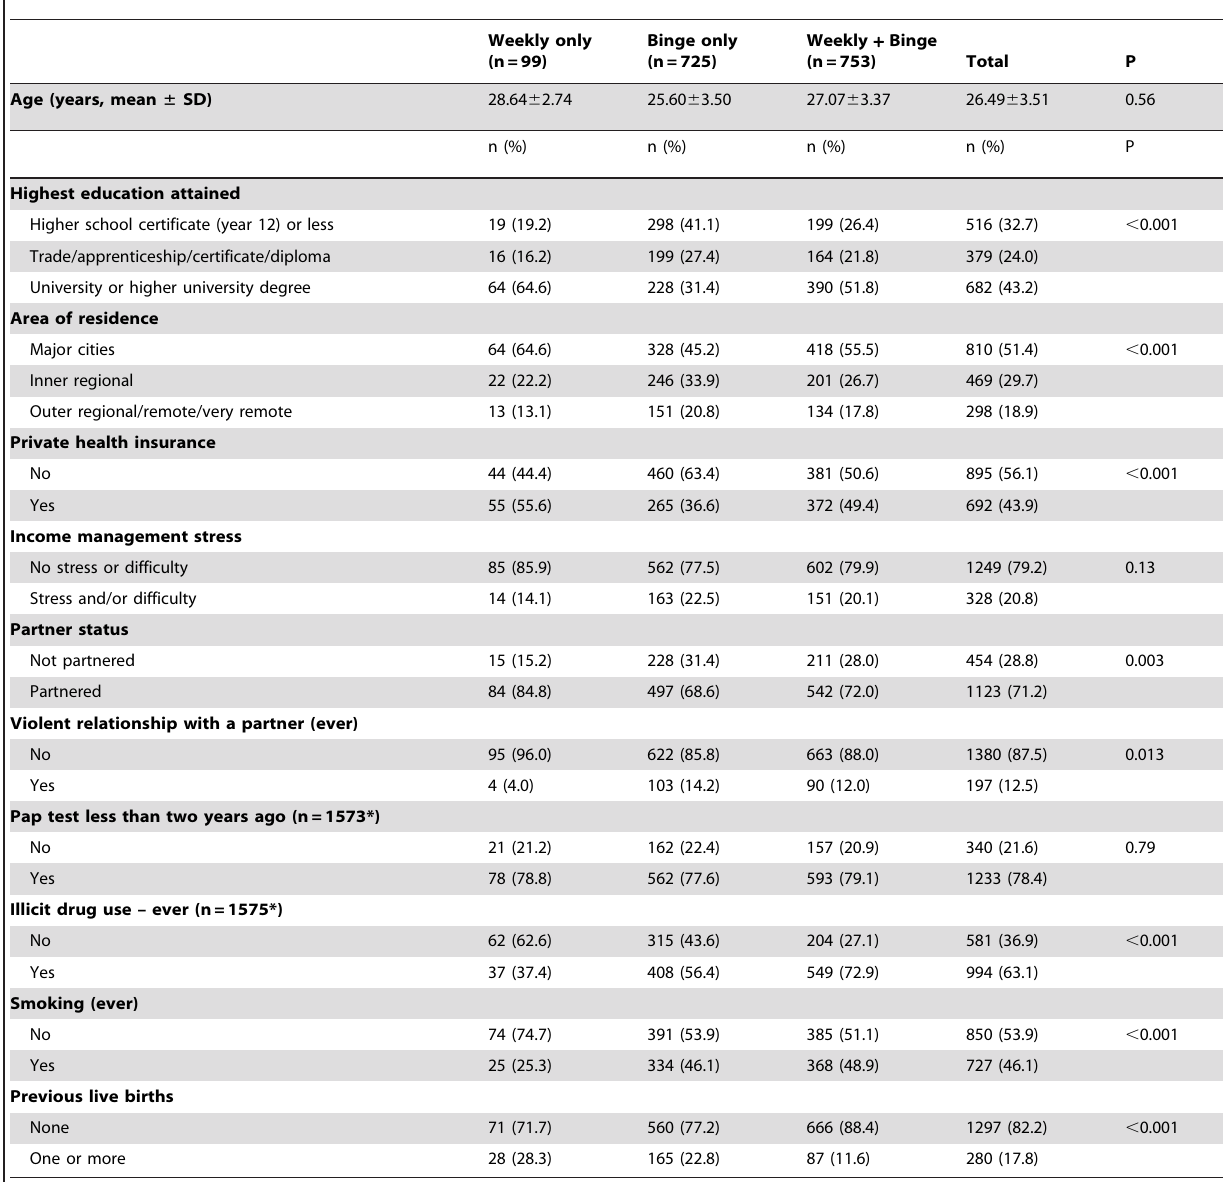
Table 1. Characteristics of women according to their risky drinking patterns prior to pregnancy (N=